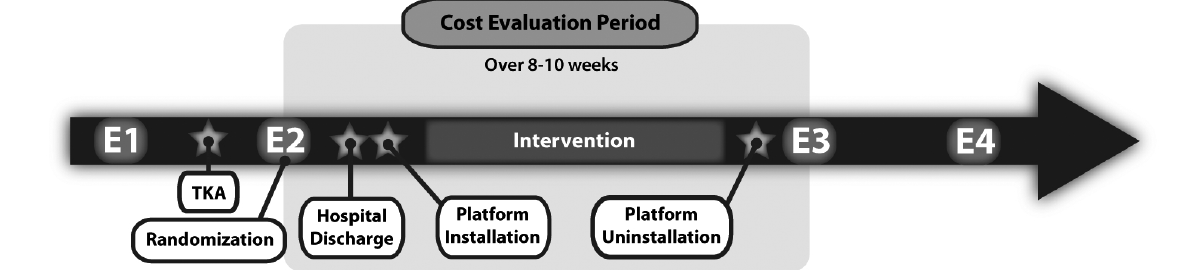
Figure 1. TelAge clinical randomized controlled trial study design including cost evaluation